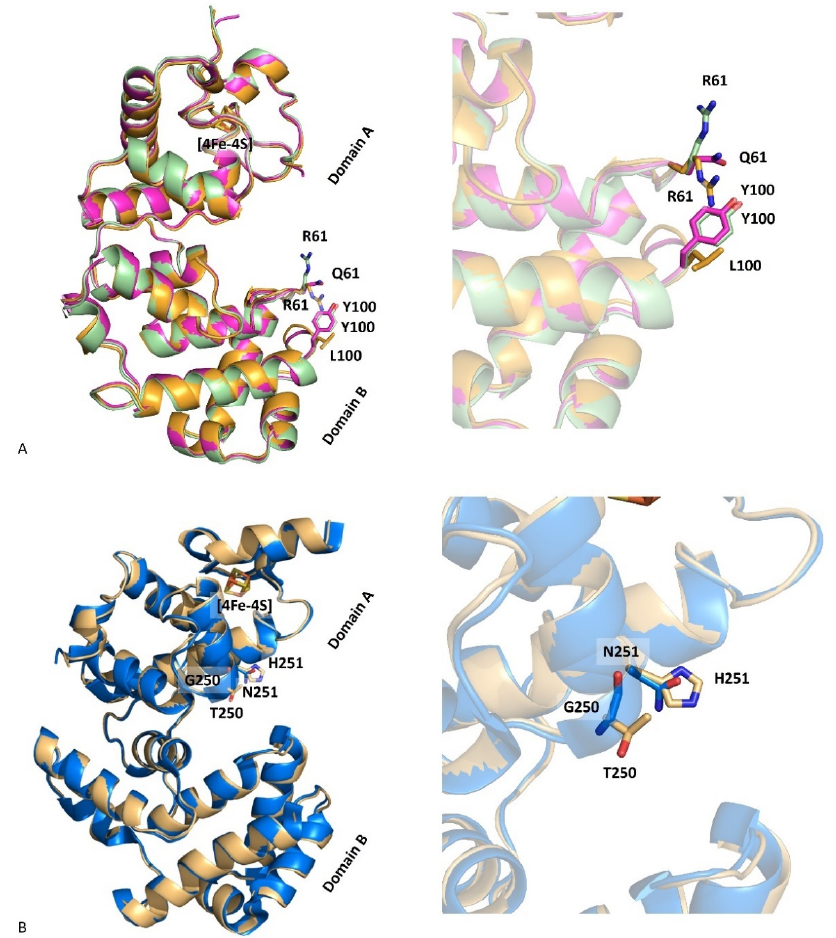
Figure 3. Superimposition of DrEndoIII1 native (cyan, 4UNF), R61Q (pink, 8A5F) and Y100L (orange, 8A5C) structures ( A ) and of DrEndoIII3 native (blue, 4UOB) and G250T/N251H (grey, 8A5G) ( B ).